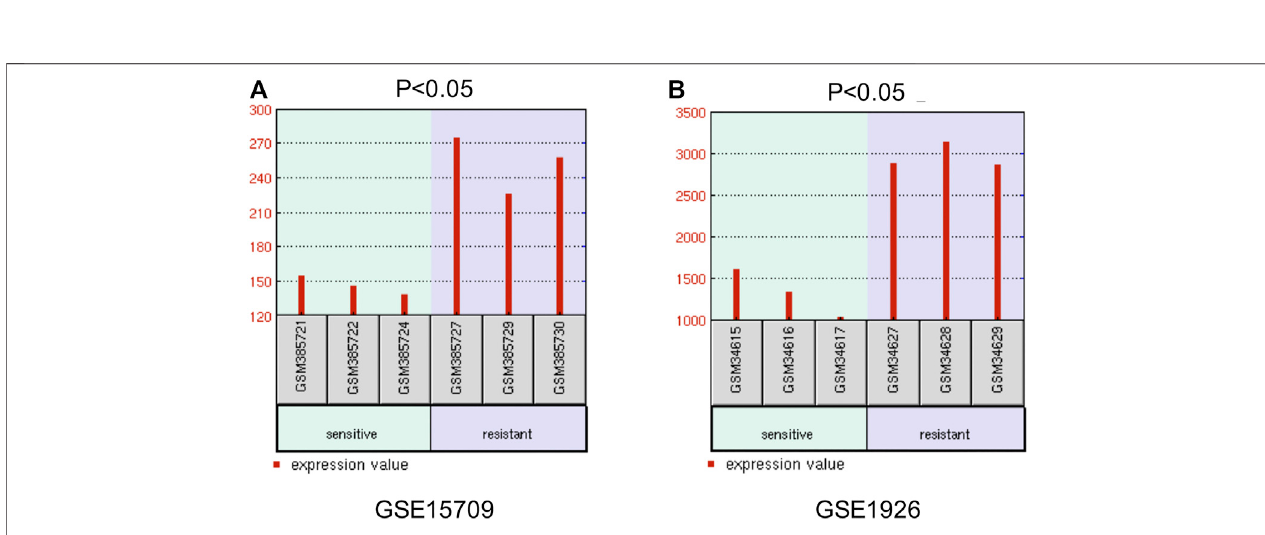
FIGURE6| TheeffectofCBX3onthetreatmentoutcomesofovariancancerpatients. (A – B) GSE15709andGSE1926aretwodatasetsrelatedtoplatinum-based chemotherapy and are used to explore the impacts of CBX3 expression levels on ovarian cancer therapy.